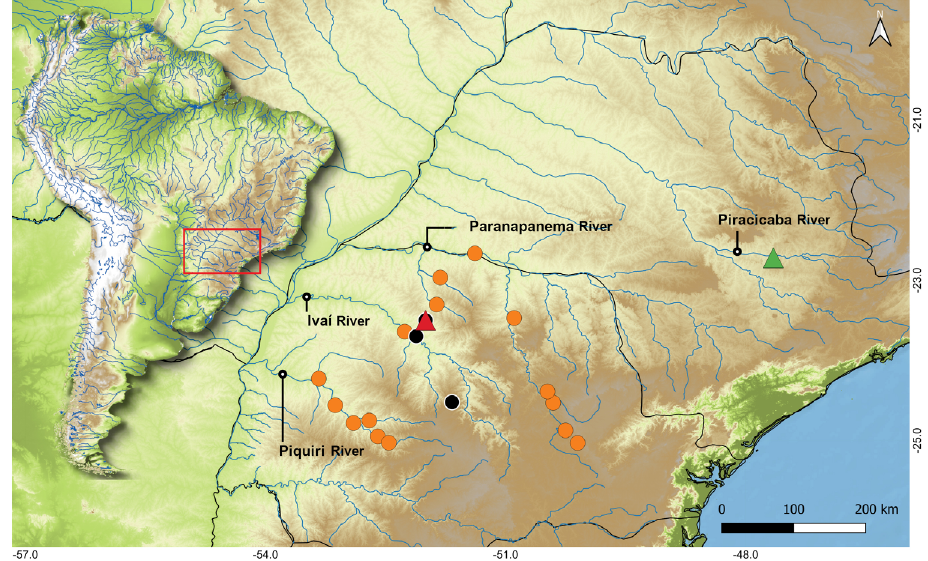
FIGURE 7 | Distribution of Hypostomus hermanni (green triangle, type-locality, and orange circles) and H. robertsoni (red triangle, type-locality, and black circles) among Upper Paraná River basin. Some marks may represent more than one record.